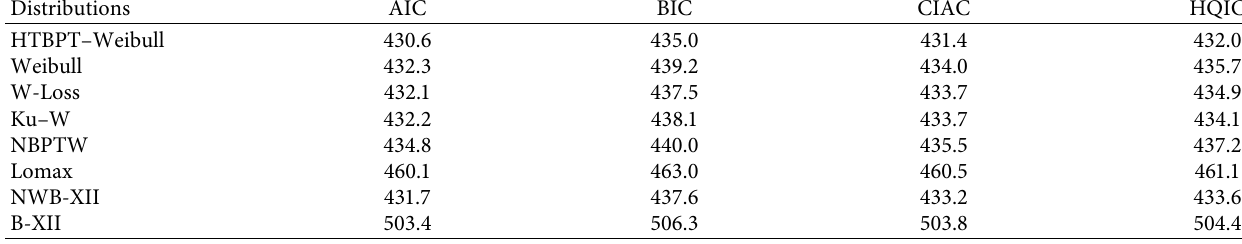
Table 7: Analytical measures of the competing models for the vehicle insurance loss